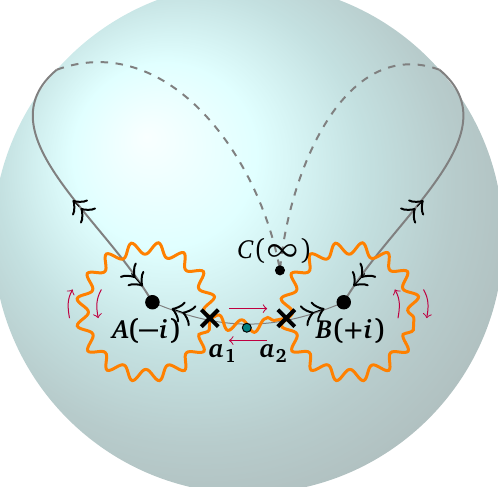
Figure 5.6: In the large N limit, for 0 < q < 1 edges γ , γ and γ of the Strebel graph, with fractions q , ( 1 − 2 q ) and q respectively. 1 2 3 As before, three “charges" attract those punctures along the Jordan arcs connecting them.